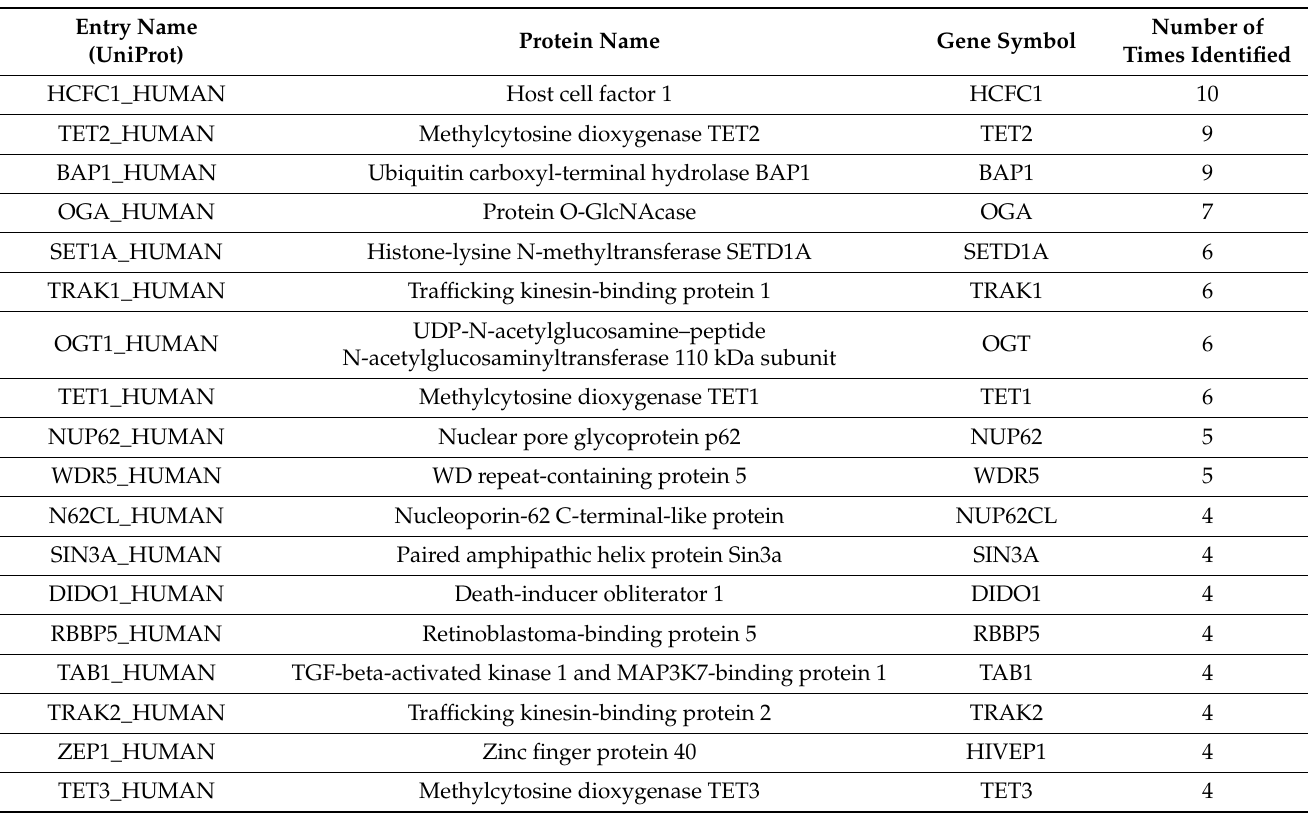
Table 1. A list of 18 human OGT-interacting proteins with the highest identification